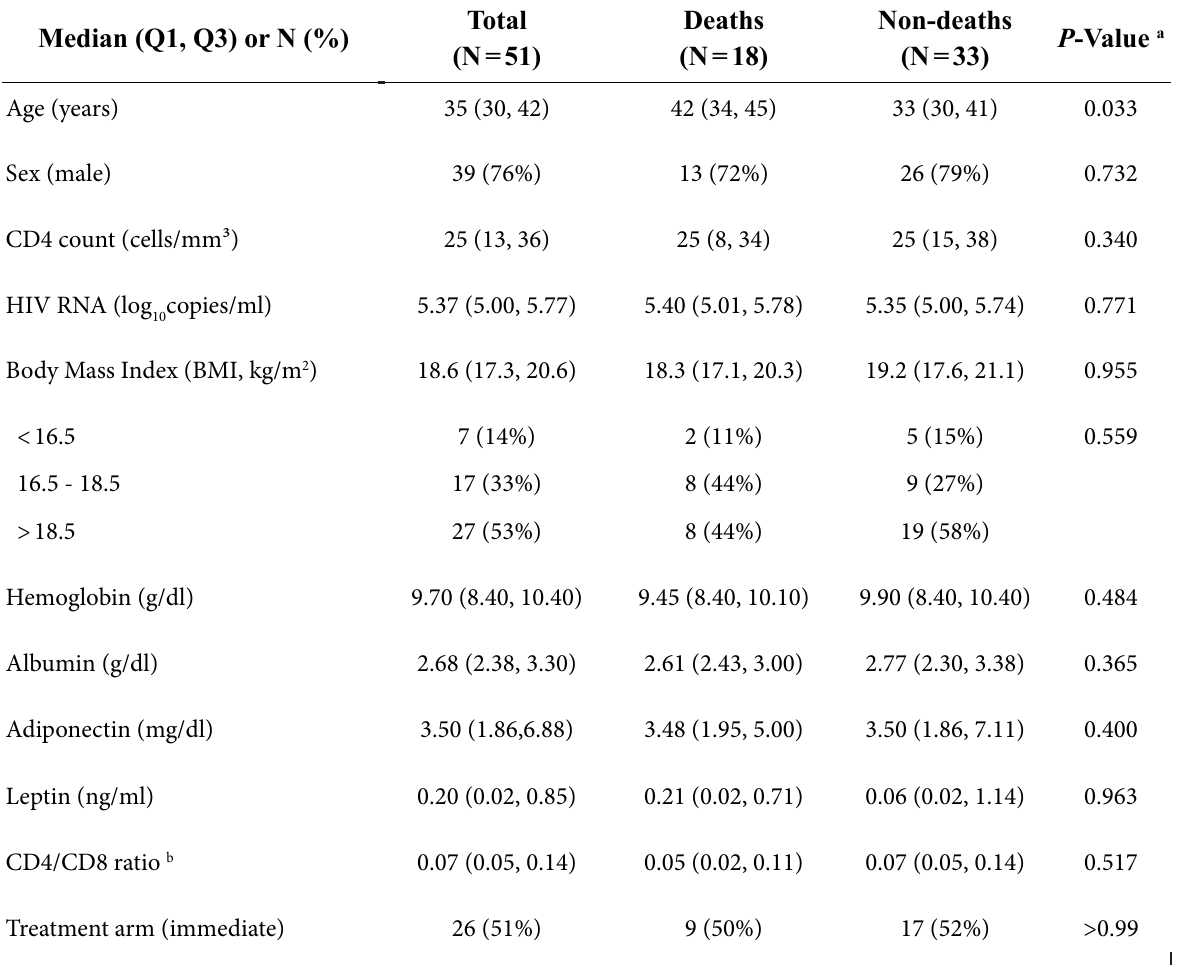
Table 1: Baseline Clinical Characteristics and Markers of Nutrition Median (Q1, Q3) or N (%)